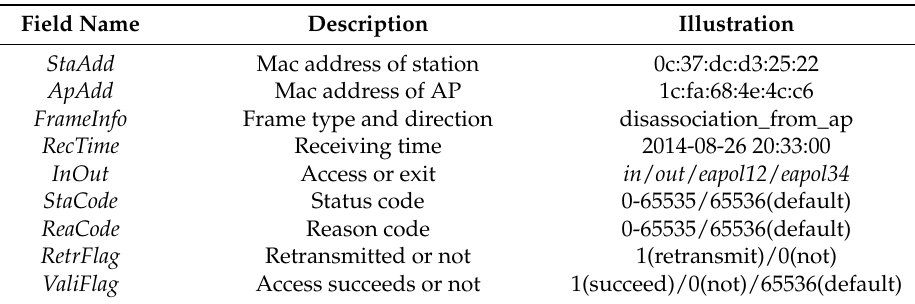
Table 3. Information fields